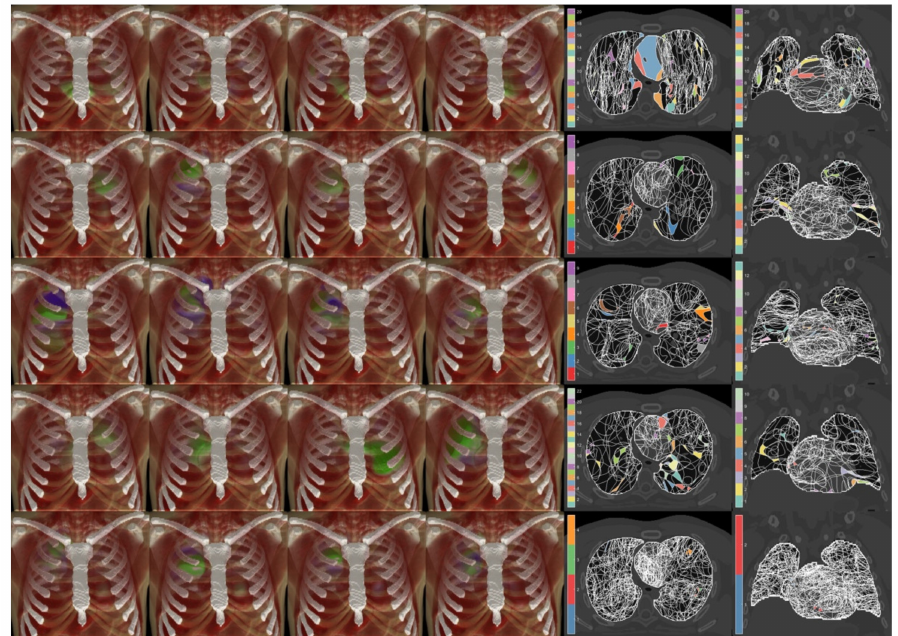
Figure 4. Probabilistic independent component analysis (PICA) of the dose distributions of Hodgkin lymphoma patients ( first row ), non-small cell lung cancer (NSCLC) patients treated with intensity-modulated radiation therapy ( second row ), NSCLC patients treated with stereotactic body RT ( third row ), NSCLC patients treated with passive-scattering proton therapy ( fourth row ), and the whole cohort of patients ( fifth row ). For each row, the first four PICA components are displayed anchored to the underlying patient anatomy, as well as the axial ( fifth column ) and coronal ( sixth column ) views of the PICA component patches exceeding the 95% confidence interval of the normal distribution (sets of patch intersections marked with the same color are connected in the 3D